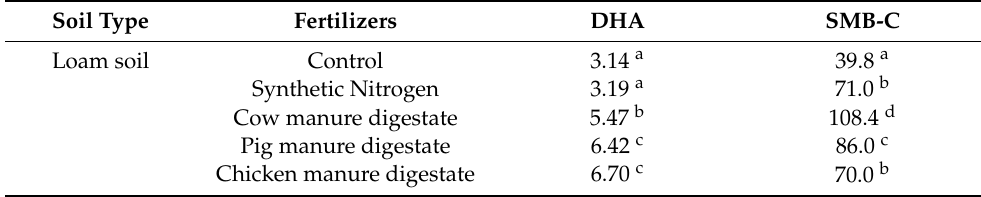
Table 5. Effect of fertilization treatment on soil microbial activities in loam soil: dehydrogenase activity and soil microbial